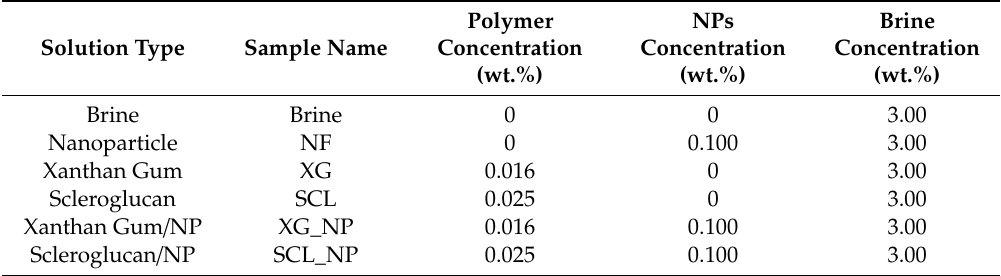
Table 2. Solutions